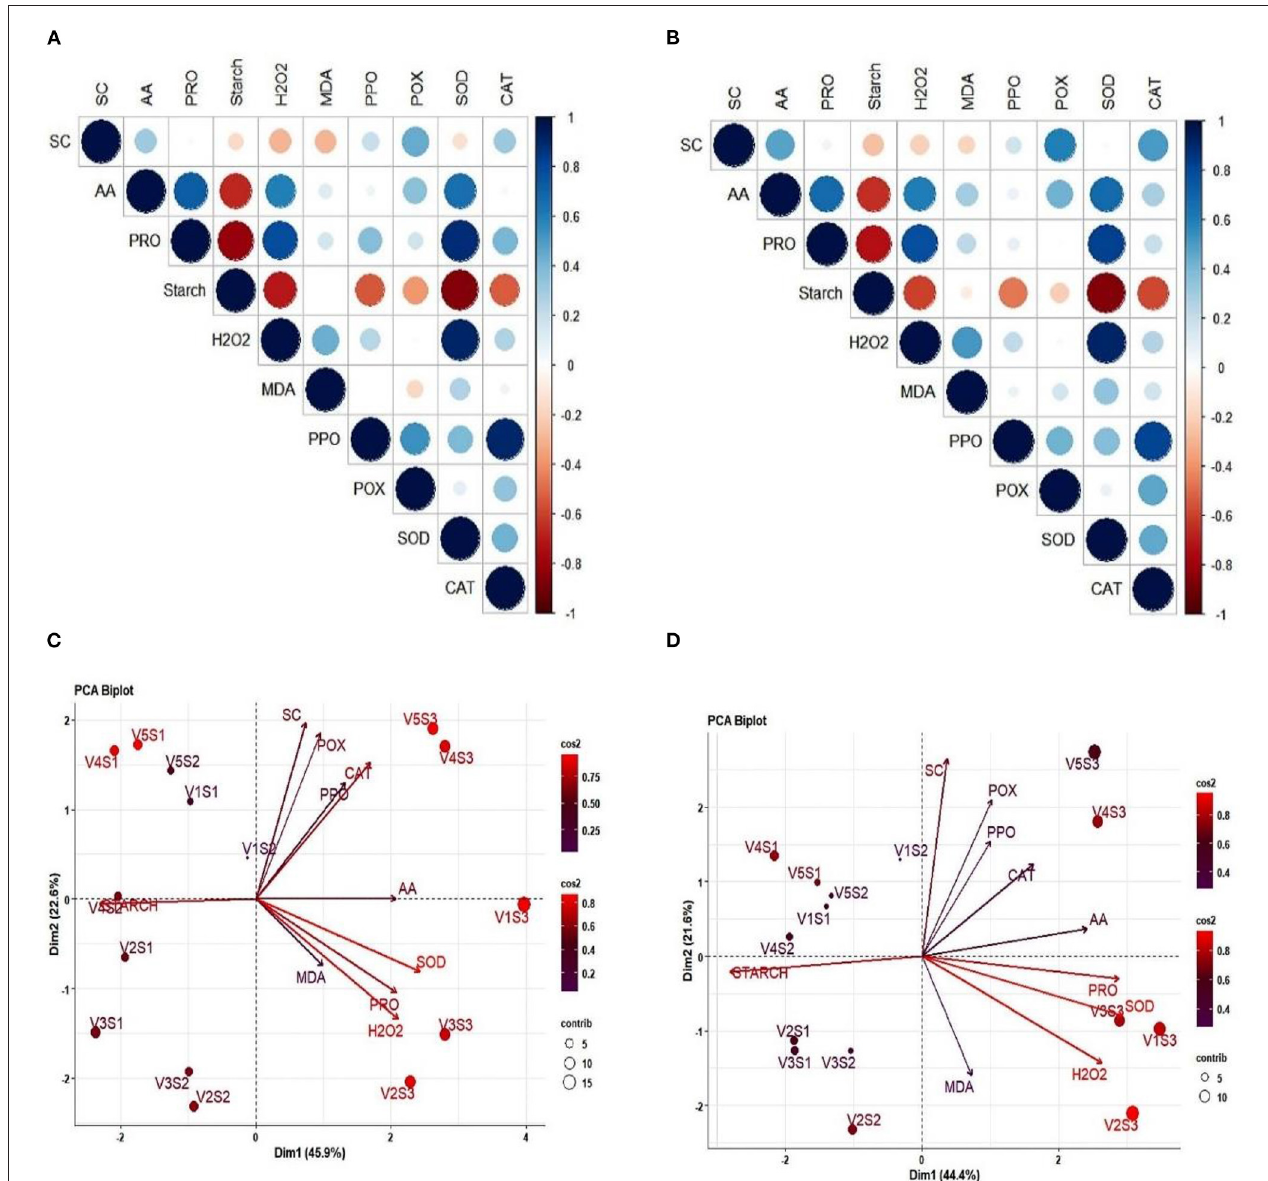
FIGURE 6 | Correlations 6 (A,B) and PCA 6 (C,D) for different biochemical traits observed in mustard genotypes sown in three different dates during 2017–2018 and 2018–2019. Panels (A,B) represents the correlation matrix using correlogram and the different colors shows the correlation between variable (blue color showed positive, while red negative) and color intensity shows the correlation coefficient matrix (dark and big circle showed the strong correlation). Panels (C,D) PCA analysis shows the principal component varied under different sowing condition and the variation values are highlighted on – x and – y -axis. V1, PM 25; V2, PM 26; V3, BPR-541-4; V4, RH-406; and V5, Urvashi. S1 timely sown (30 October), S2 late sown (15 November), and S3 very late sown (30 November), respectively. Superoxide dismutase activity (SOD), hydrogen peroxide (H 2 O 2 ), proline content (Pro), peroxidase (POX) activity, sugar content (SC), and catalase (CAT) activity, polyphenol oxidase (PPO), and malondialdehyde (MDA)